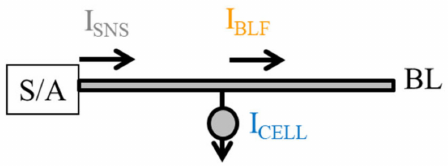
Figure 5. Definition of current